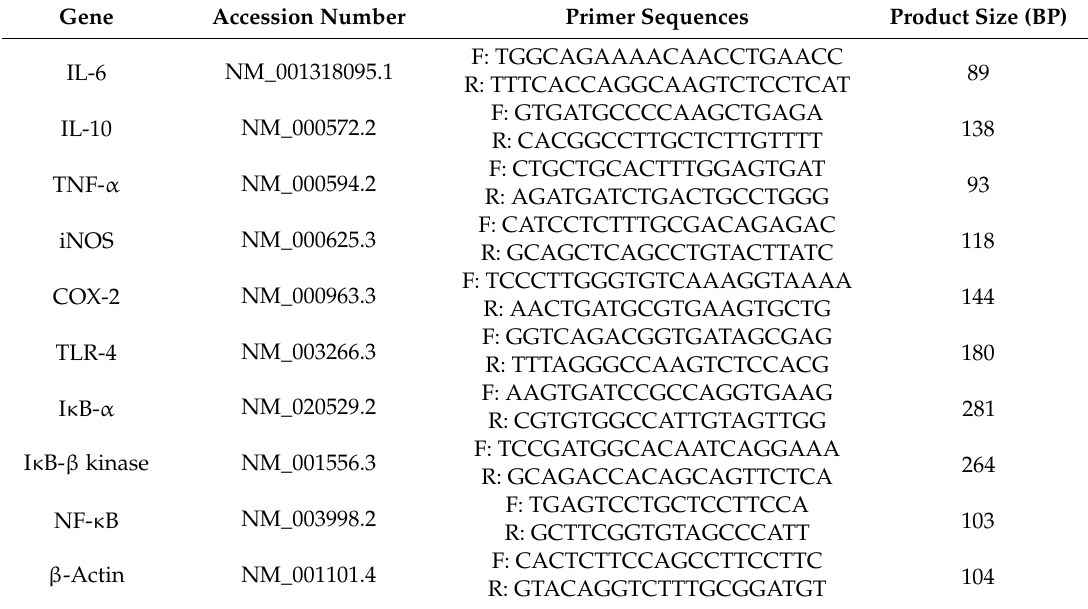
Table 1. Primer sequences used for